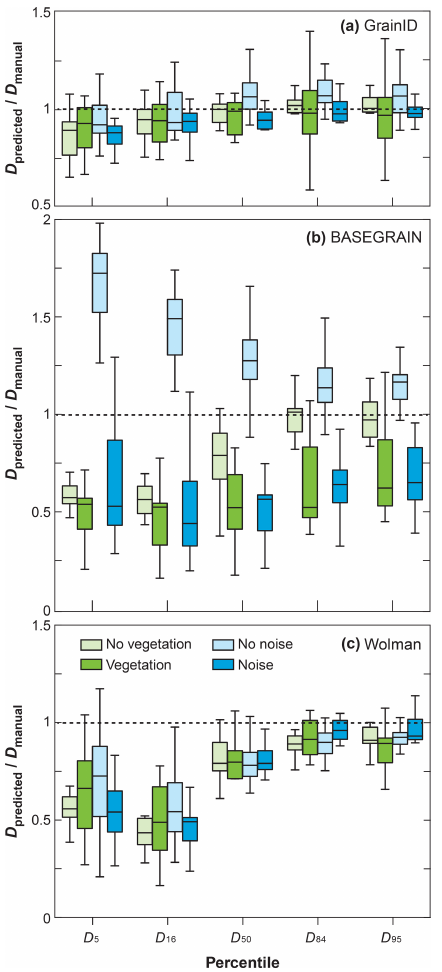
Figure 7. Ratio of predicted to baseline grain size value shown for different D i for the (a) GrainID, (b) BASEGRAIN and (c) Wolman methods in environments with and without vegetation and inter- granular